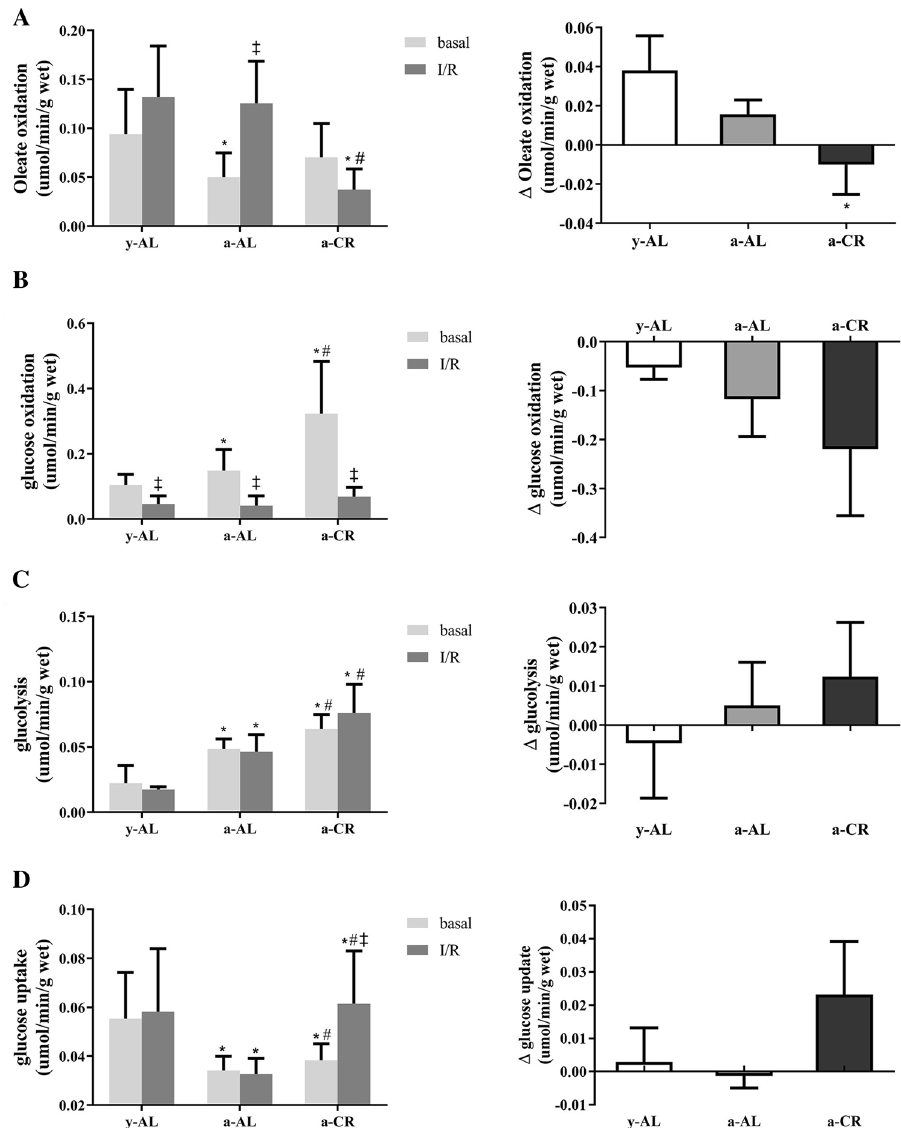
Figure 5. Analysis of substrate metabolism in the hearts. Oleic acid oxidation ( A ) and glucose oxidation ( B ) were measured in isolated working hearts. The hearts were intravenously infused with buffers containing [9, 10-3H 2 O] and [ 14 C] for equilibrium for 20 min, then underwent ischemia for 10 min, followed by reperfusion for 40 min. Glycolysis ( C ) and glucose uptake ( D ) were measured using d-[5–3h] glucose or d-[2–3h] glucose in the Langendorff system, respectively. The delta (Δ = rep-basal) gradient between aerobic and reperfusion was calculated in all four graphs. * P < 0.05 vs y-AL; # P < 0.05 vs a-AL; ‡ P < 0.05 vs the base